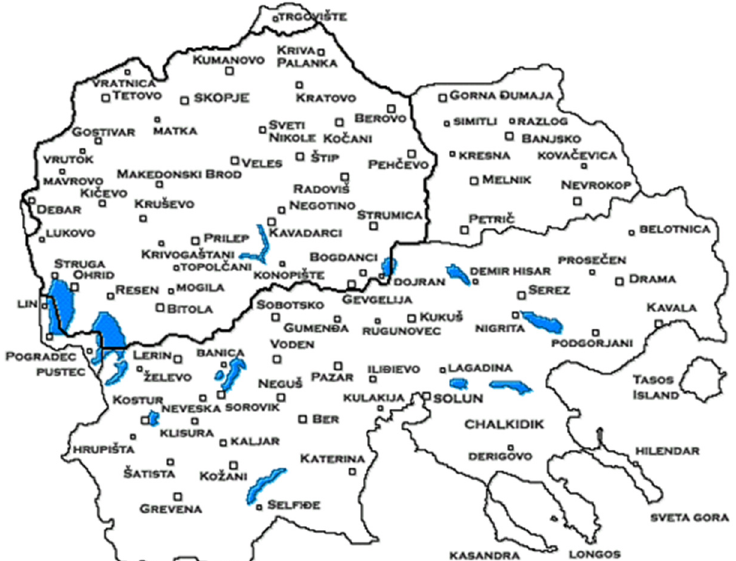
Figure 1. Map of the region of Macedonia.